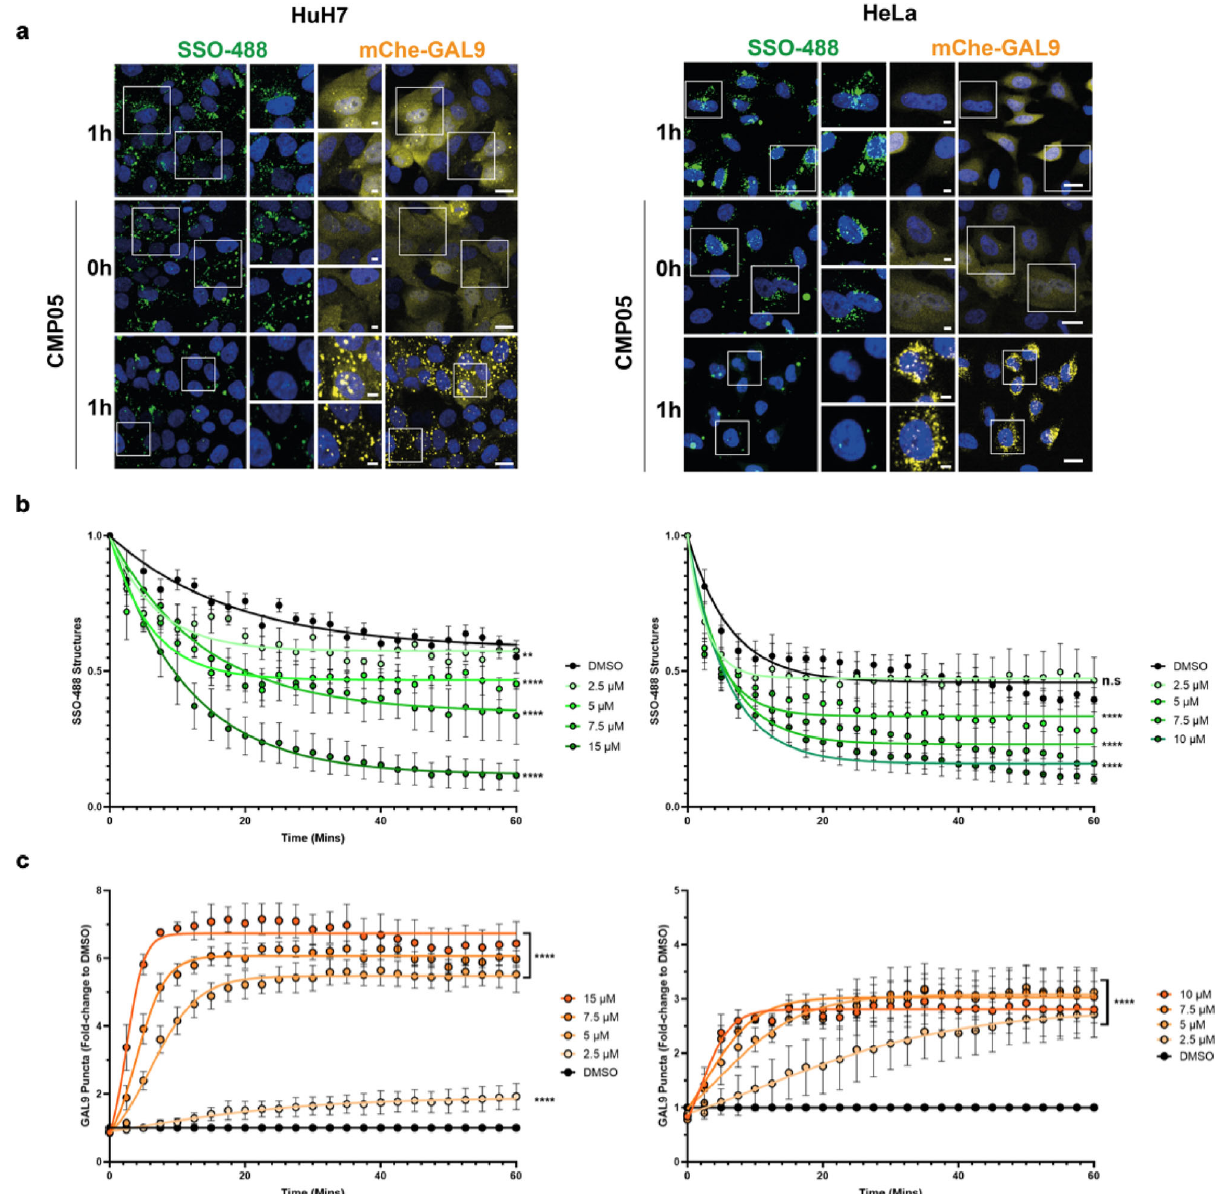
containing bodies and Gal9 translocation. HuH7_mCherry-Gal9 and HeLa_mCherry-Gal9 were pre-loaded with SSO-488 (green) for 24 h and then treated with various concentrations of CMP05 and Hoechst to visualize nuclei (blue). Gal9 events appear as yellow puncta. Scale bars = 20 µ m (larger panels) and 5 µ m (insets). White boxes indicate inset regions. b Quantitative analysis of cells treated as in a and imaged every 2.5 min. Analysis reveals a time and dose-dependent decrease in the total number of SSO-488 structures per cell. Data represent mean − / + SEM from n = 3 independent experiments. c Cells treated as in ( b ) and quantitation of mCherry-Gal9 puncta formation. Analysis displays a dose and time-dependent increase of Gal9 structures per cell. Data represent mean − / + SEM from n = 3 independent experiments. Signi fi cance was determined by two-way ANOVA followed by Dunnett ’ s posttest to the DMSO control where **** P < 0.0001 and n.s = not signi fi